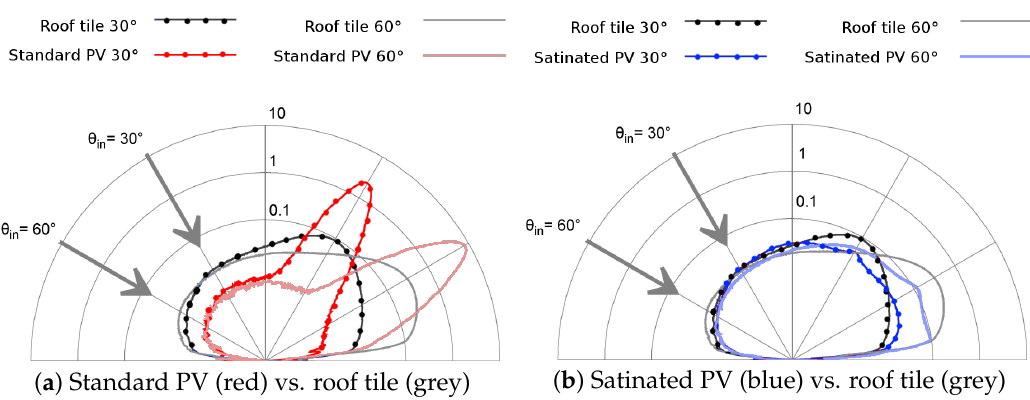
Figure 8. Polar BSDF plots of standard ( a ) and satinated ( b ) PV modules for incident angles of 30 ◦ and 60 ◦ . Corresponding BSDF plots of the existing roof tile are superimposed for